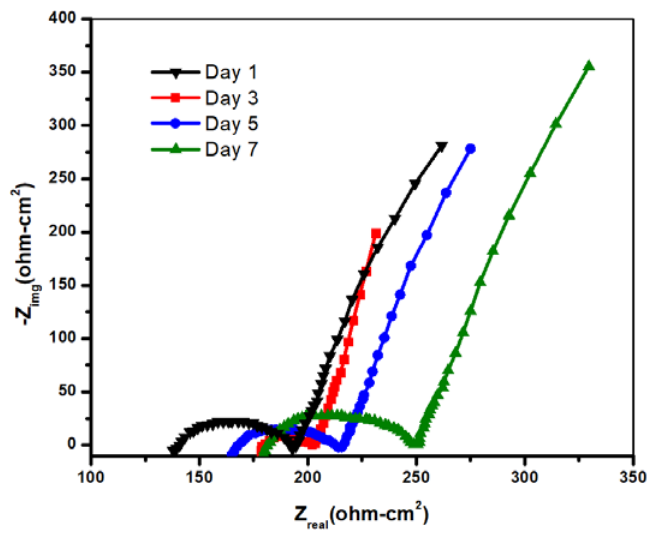
Figure 5. Nyquist plot of MFC anode.